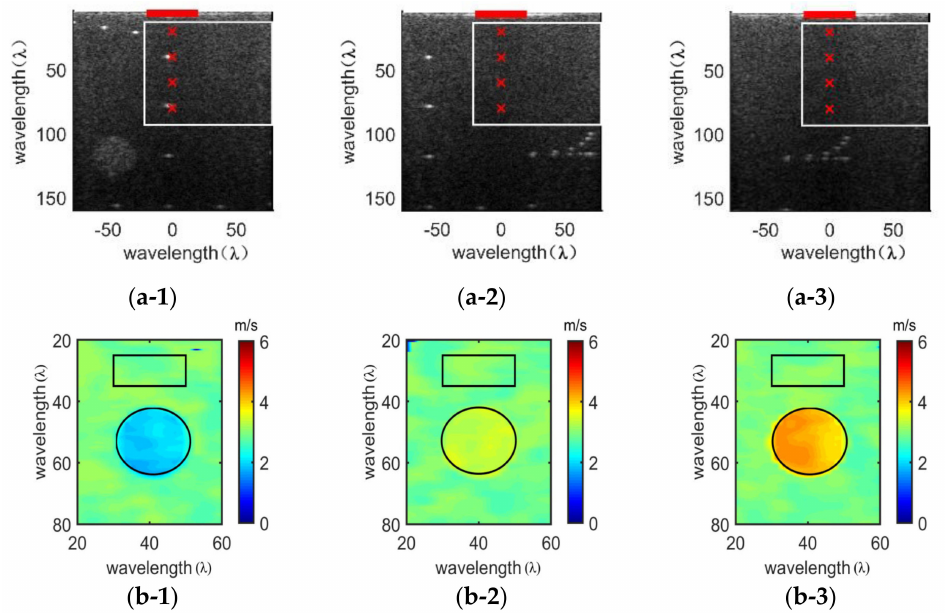
Figure 6. Velocity image reconstruction of the stiff spherical inclusion with the real-time curve tracing method. ( a ) The B-ultrasound image of region of interest. ( b ) The velocity imaging. ( a-1 ) The B- ultrasound image of the region containing a stiff spherical inclusion of 10 kPa. ( a-2 ) The B-ultrasound image of the region containing a stiff spherical inclusion of 40 kPa. ( a-3 ) The B-ultrasound image of the region containing a stiff spherical inclusion of 60 kPa. ( b-1 ) The velocity image of the region containing a stiff spherical inclusion of 10 kPa. ( b-2 ) The velocity image of the region containing a stiff spherical inclusion of 40 kPa. ( b-3 ) The velocity image of the region containing a stiff spherical inclusion of 60